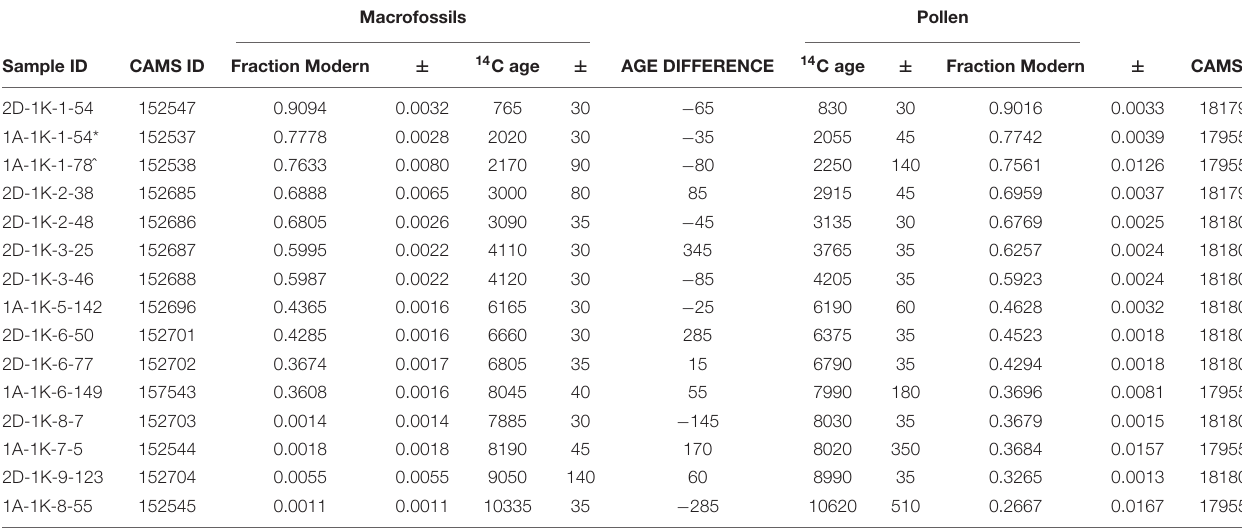
TABLE 3 | Comparison between macrofossils and pollen dates on FLL core